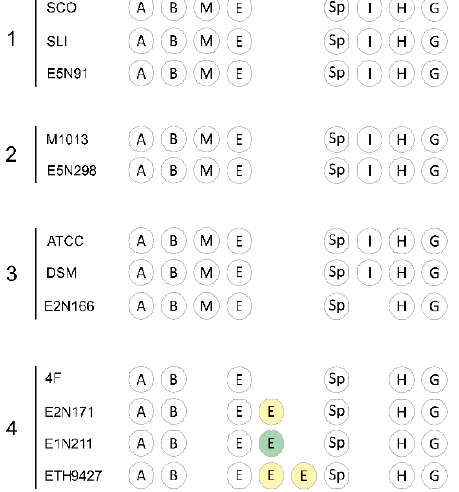
Figure 3. The core specialized metabolites produced by the strains. From the total number of SMBGCs that were identified, the core metabolome constitutes a set of gene clusters frequently conserved across Streptomyces species. The letters stand for the specialized metabolites albaflavenone (A), desferrioxamine B (B), melanin (M), ectoine (E), spore pigment (Sp), isorenieratene (I), hopene (H), and geosmin (G). Cluster disposition is not related to chromosomal position. The ectoine clusters in yellow and green represent different gene clusters.